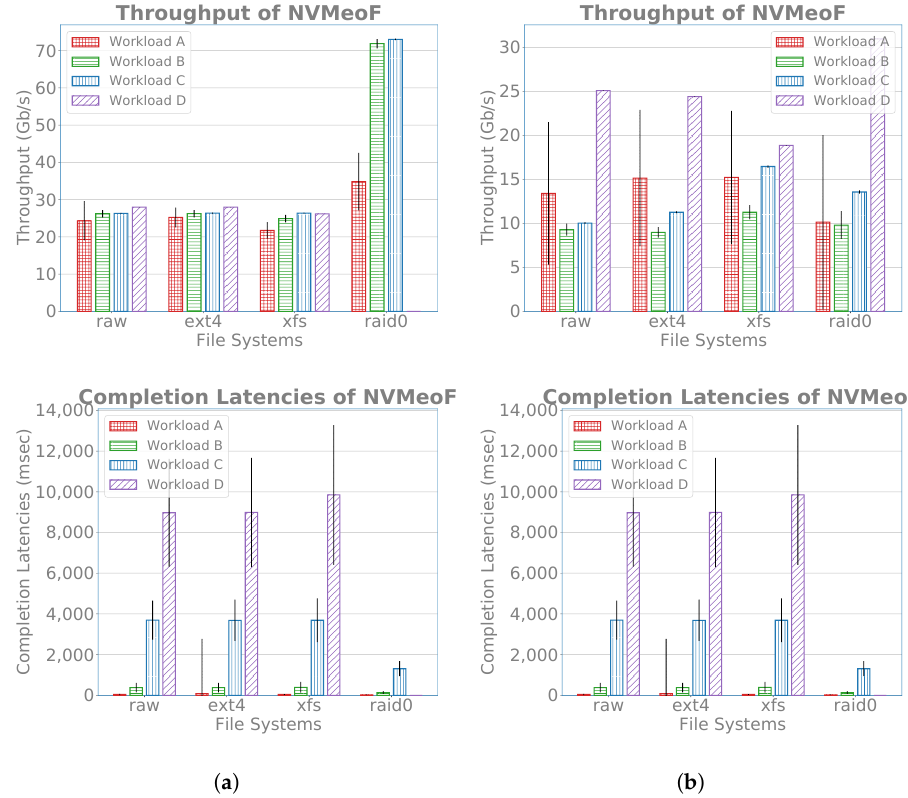
Figure 2. Baseline average and standard deviation of read ( a ) and write ( b ) performance for UIC DTN. Compared to the read throughput, write throughput with smaller concurrent file writes are significantly slower even with RAID0, suggesting that we need multiple file I/O to get the optimal throughput with NVMe-TCP. In addition, the completion latency for remote write is higher than the remote read, which results in a lower overall remote write